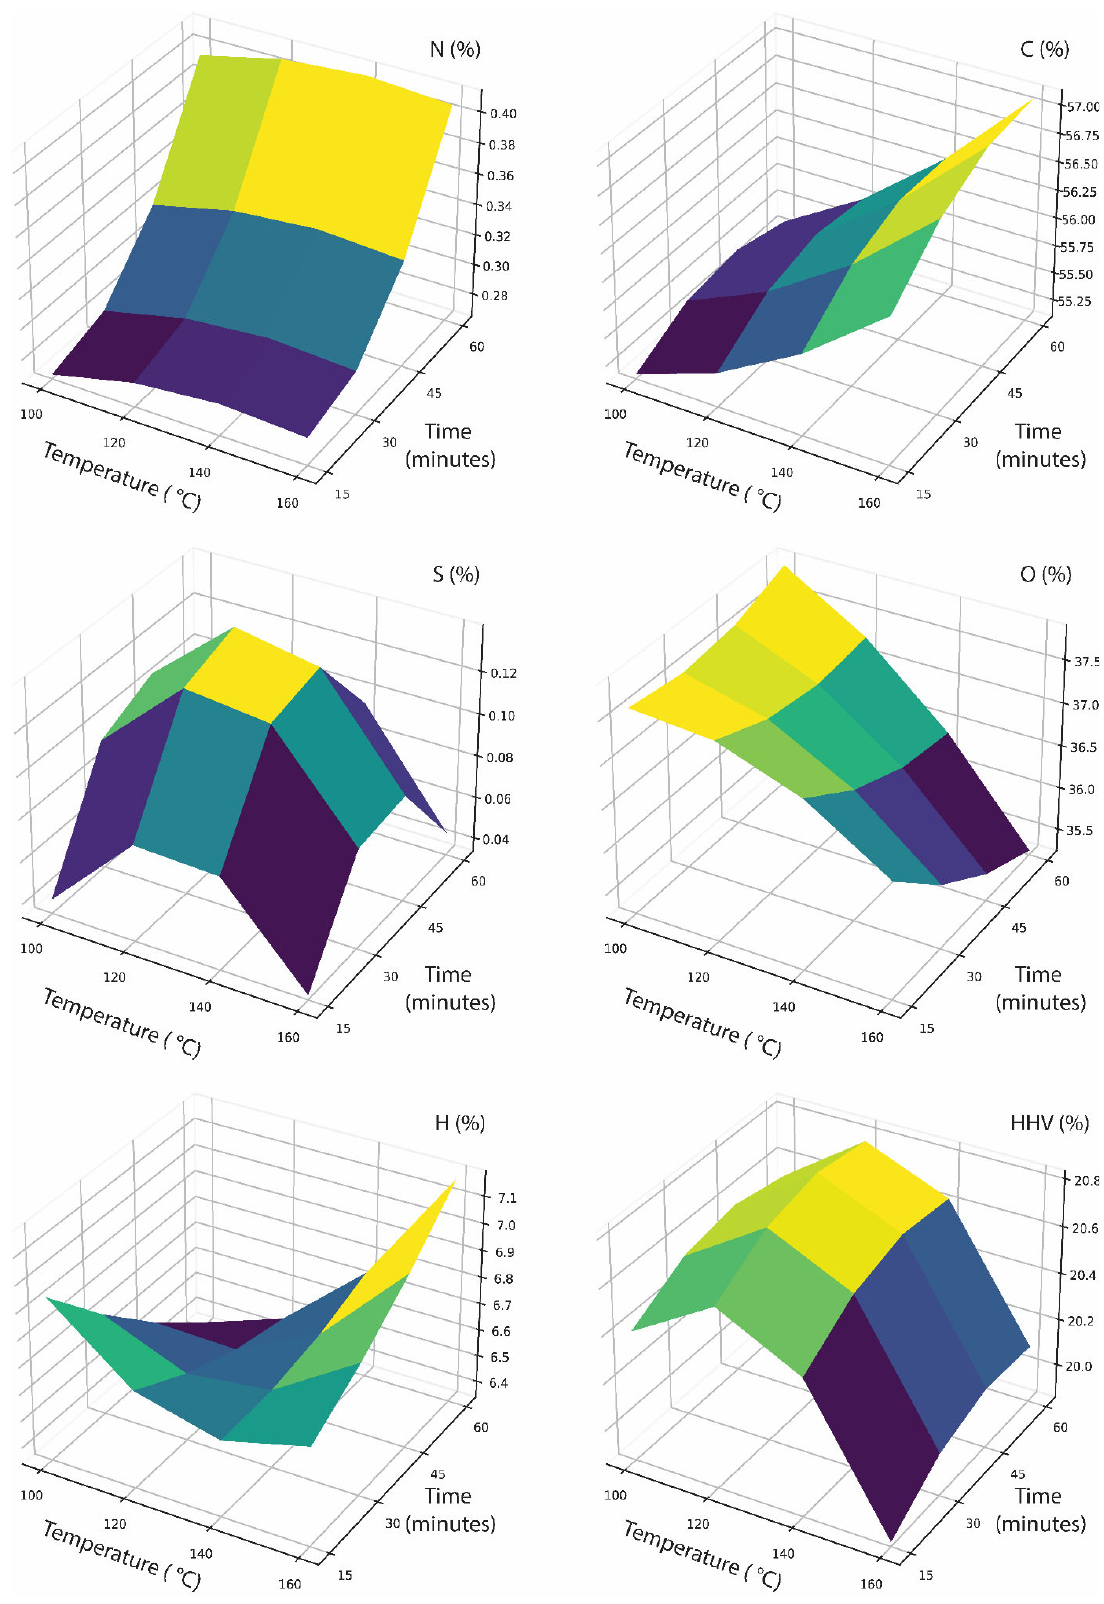
Figure 2. Response surface methodology (RSM) for fitting second-degree polynomial models in order to predict variables in ultimate and calorimetric analysis as a function of temperature and time.